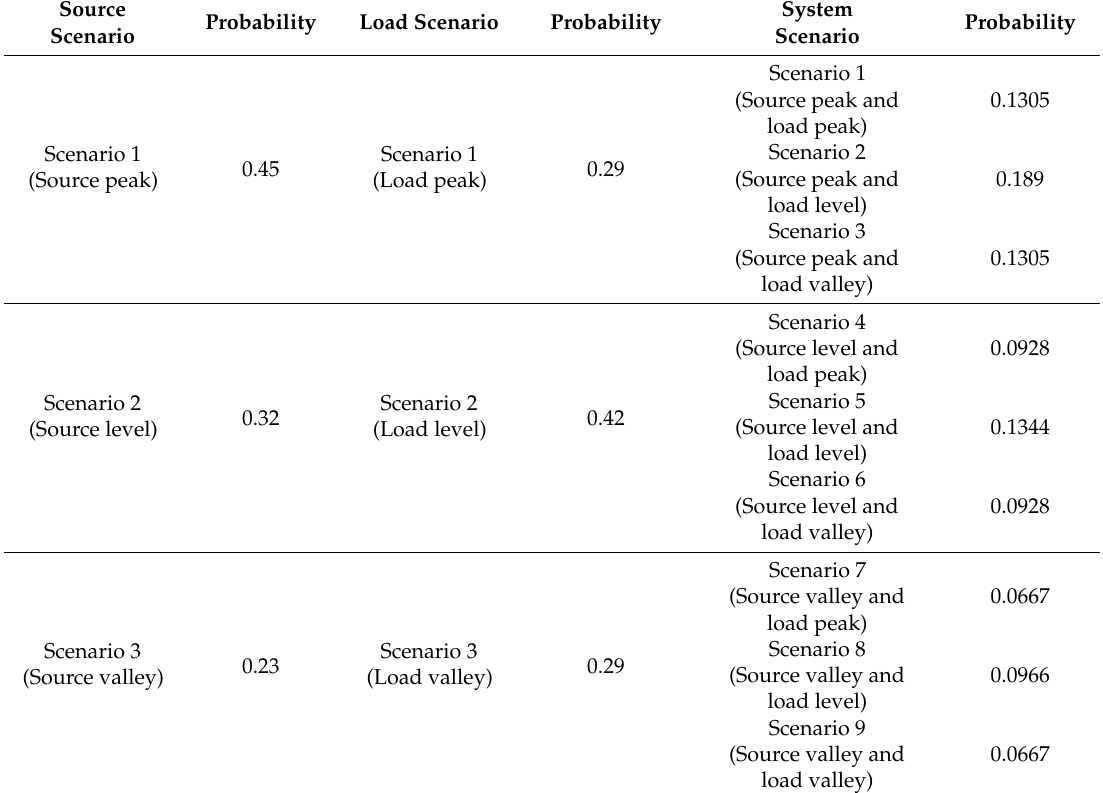
Table 4. Probability of Typical Scenarios of